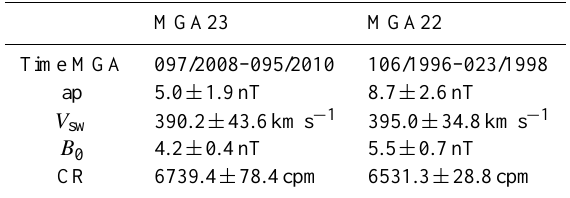
Table 1. Average values for MGA23 and